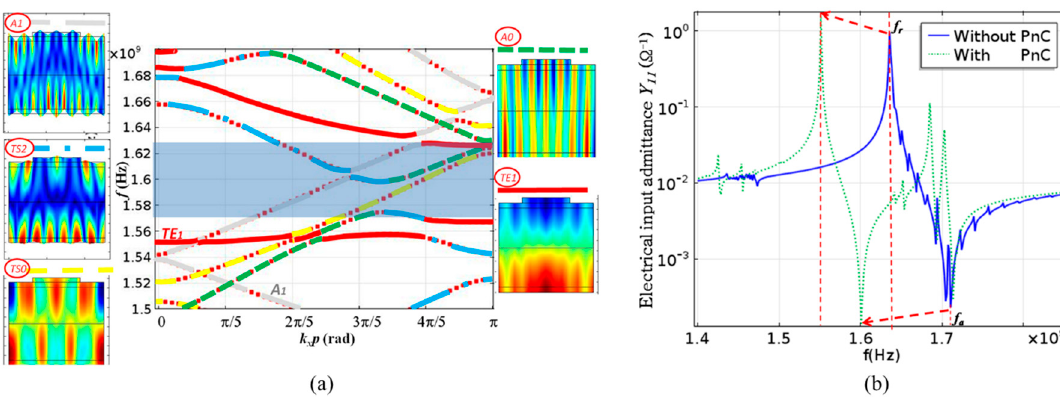
Figure 13. ( a ) Dispersion curve of acoustic waves in the FBAR; the formation of PnC directly bans the TE1 spurious mode generation at the antiresonance frequency [93]. ( b ) Comparison between the calculated input admittances of FBAR without PnC and with PnC. The resonant frequency decreases due to the mass-loading e ff ect, and the curve becomes smooth as the Q-value increases [93]. Reproduced with permission from [93].